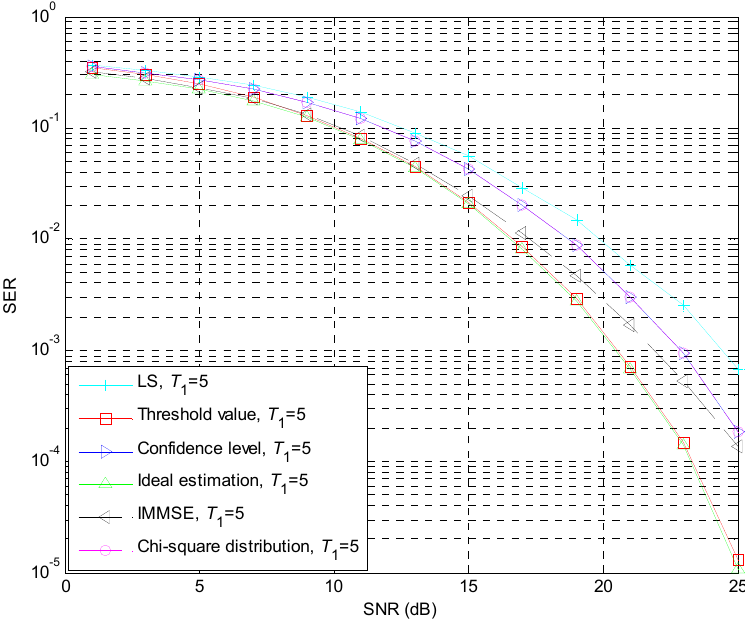
Figure 5. SER performance of the 16 QAM-modulated CP-OFDM system over static CDT1. LS: least square; IMMSE: improved minimum mean square error.